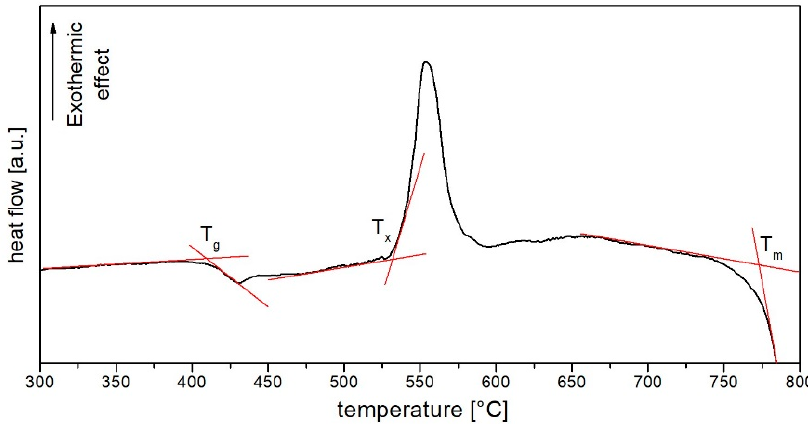
Figure 1. The DSC curve of the produced HMO un-doped glass.